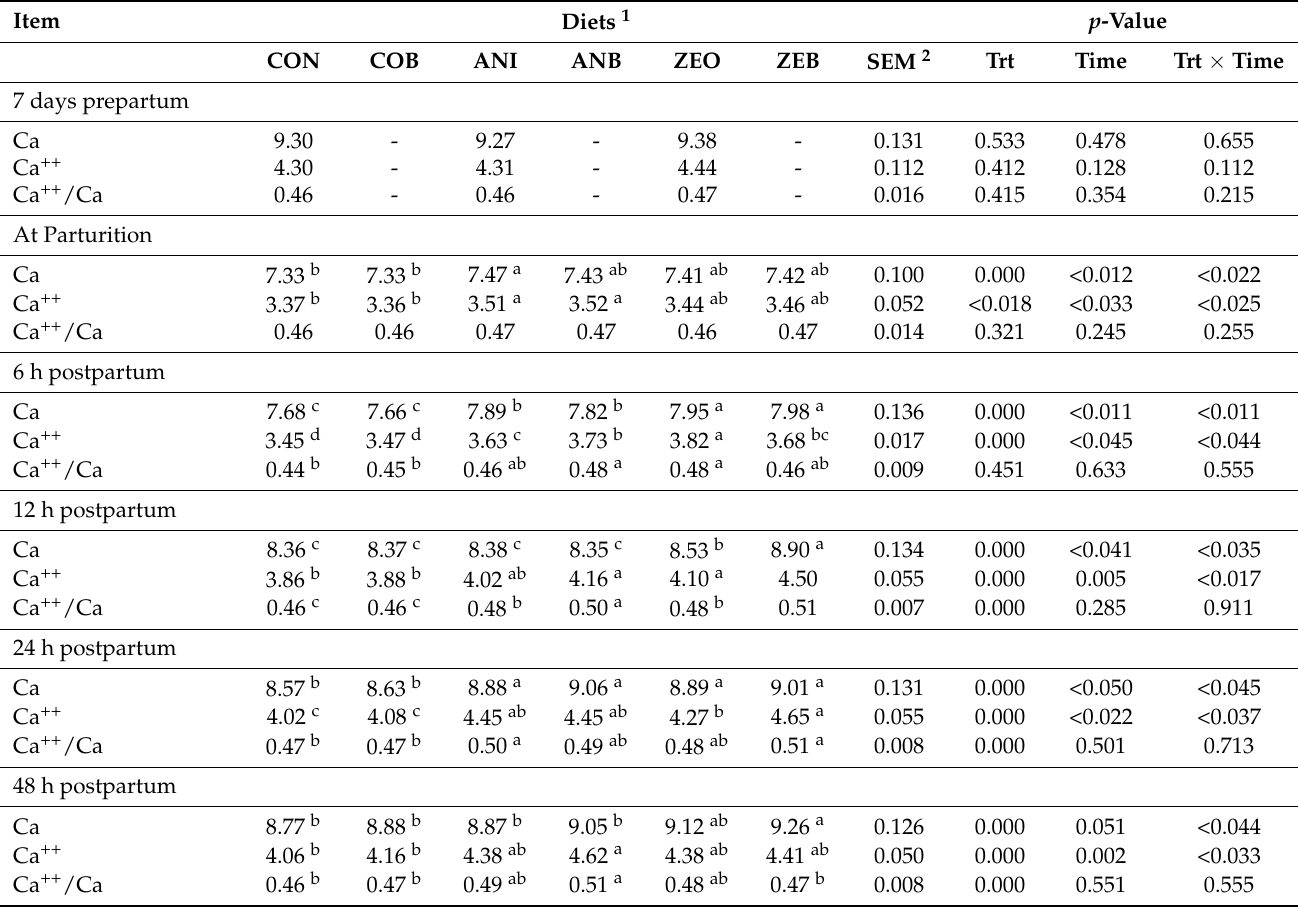
Table 4. Effect of experimental diets on plasma calcium concentration at parturition time and 48 h after that